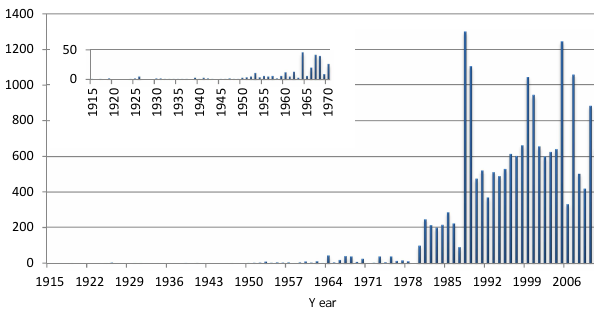
Table 2. Statistics of the